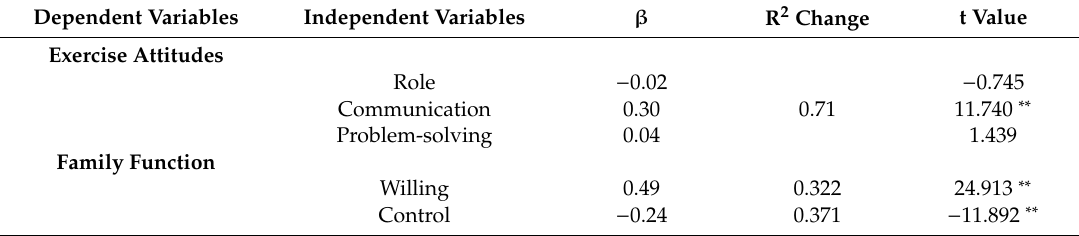
Table 3. Regression test results of drug dependents’ exercise attitudes and family